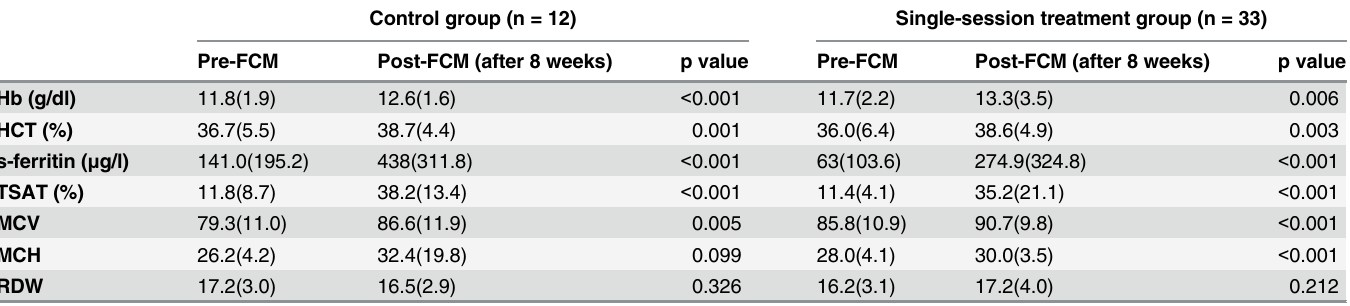
Table 2. Major hematologic parameters pre- and post-ferric carboxymaltose